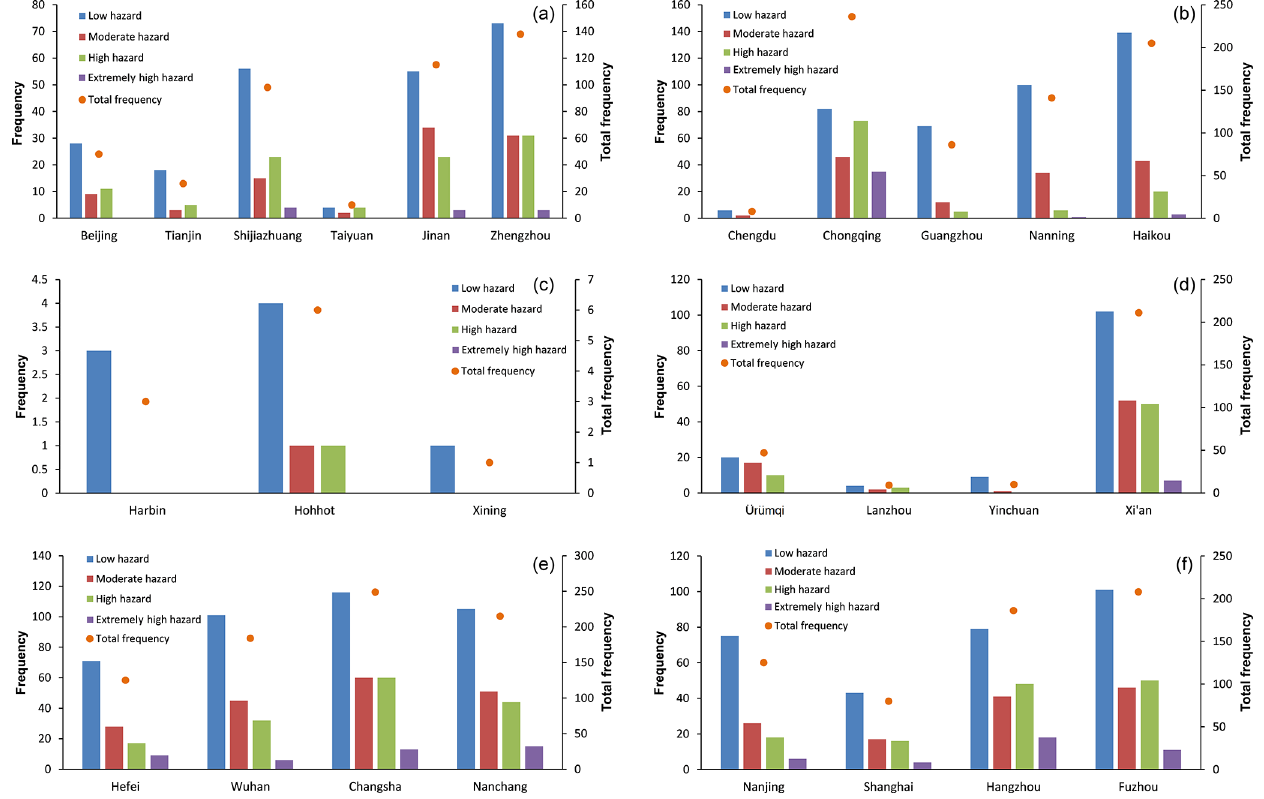
Figure 7. Frequency of low, moderately, high and extremely high HW hazards in 26 cities from 1955 to 2014 – (a) NC, (b) SW and SC, (c) NE, (d) NW and QT, (e) CC and (f) EC. There have been no HWs in Changchun, Shenyang, Guiyang, Kunming and Lhasa cities in the past 60 years. Therefore there are 26 cities shown in this figure.